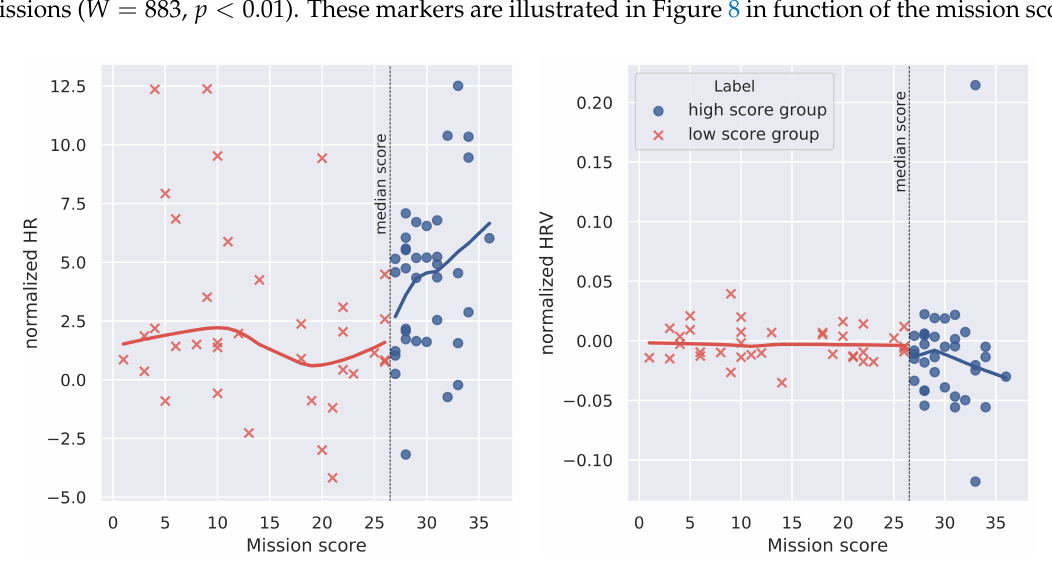
Figure 8. Normalized HR and HRV markers by performance group plotted in function of the final mission score. Each plotted point relates to one of the 72